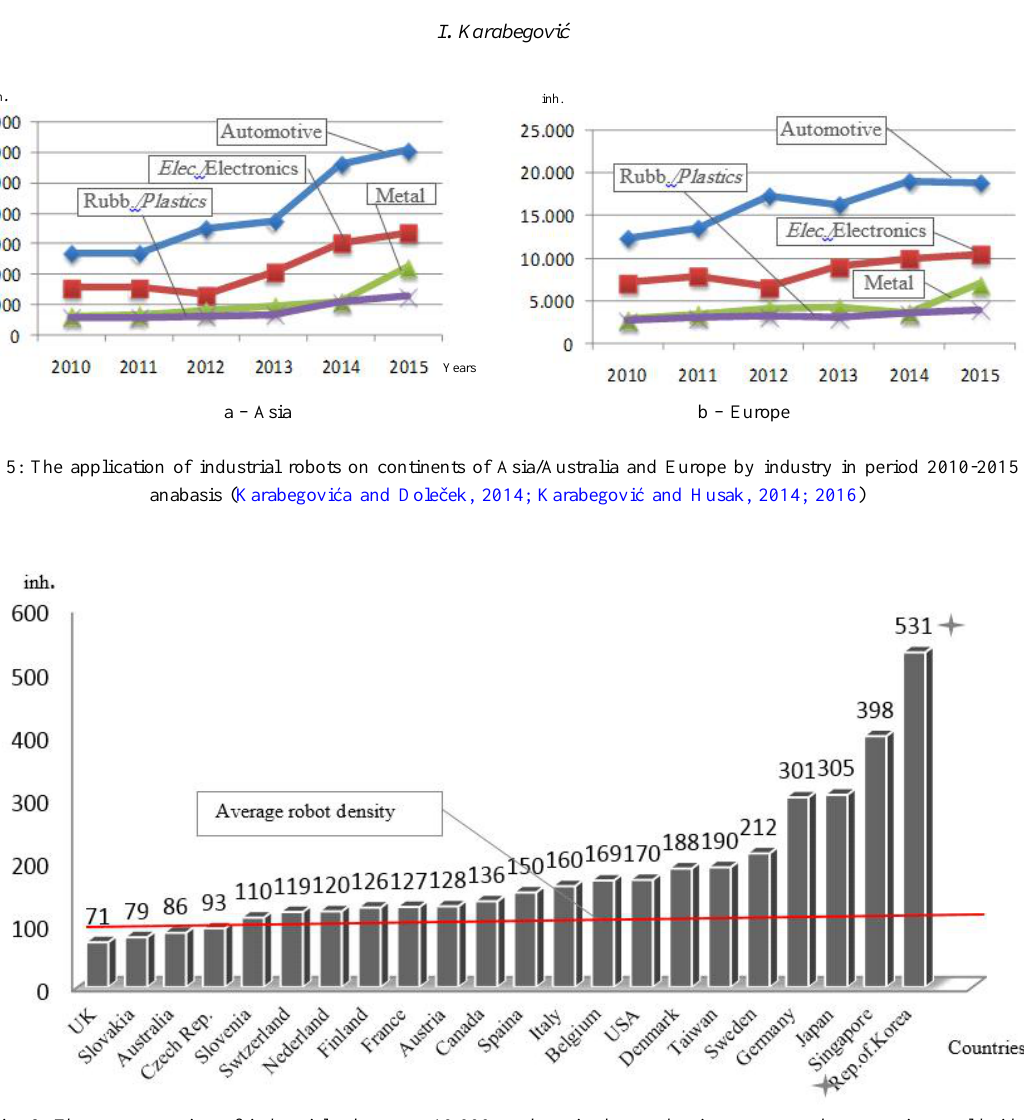
Fig. 6: The representation of industrial robots per 10.000 workers in the production processes by countries